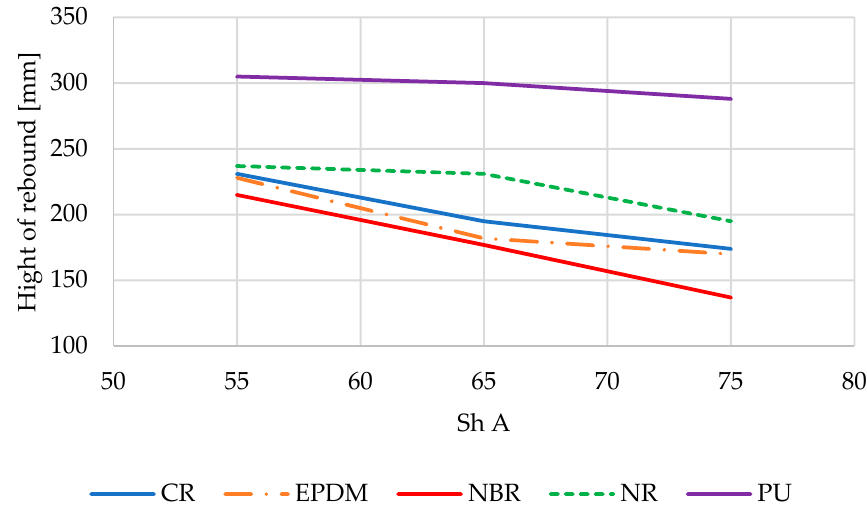
Figure 9. Hight of rebound of all tested shock absorbers dropped from 0.45 m.